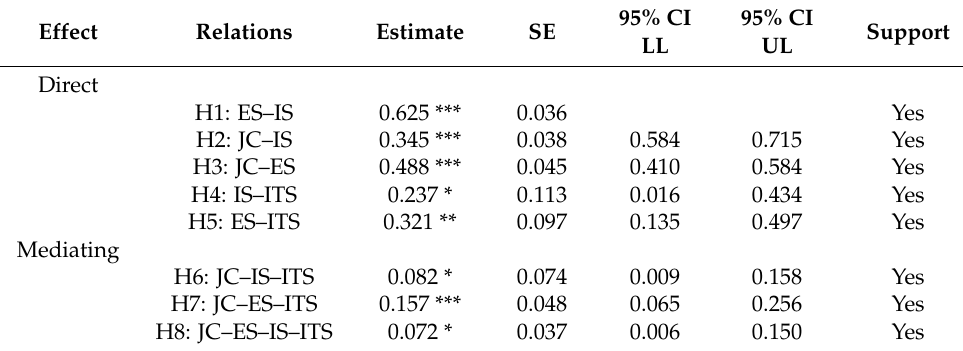
Table 3. Hypothesis